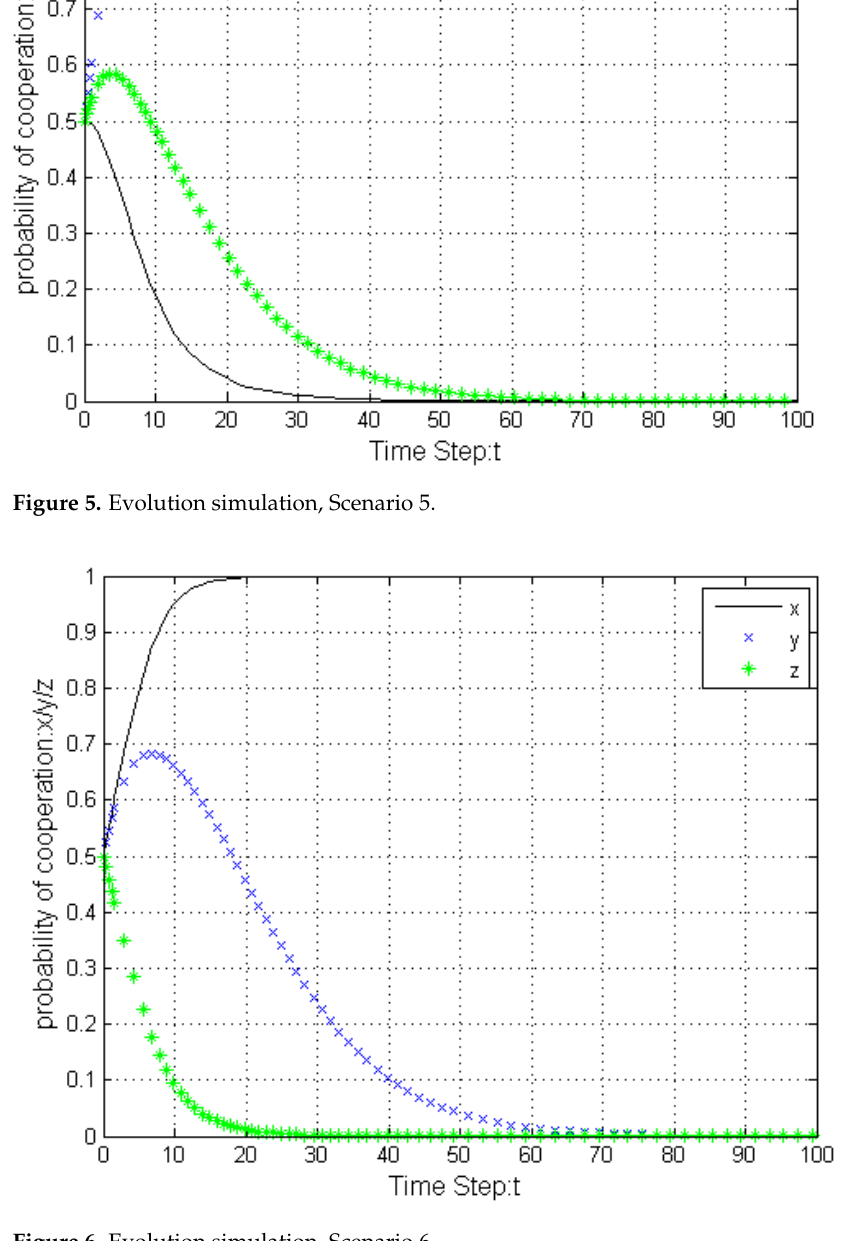
Figure 6. Evolution simulation, Scenario 6.